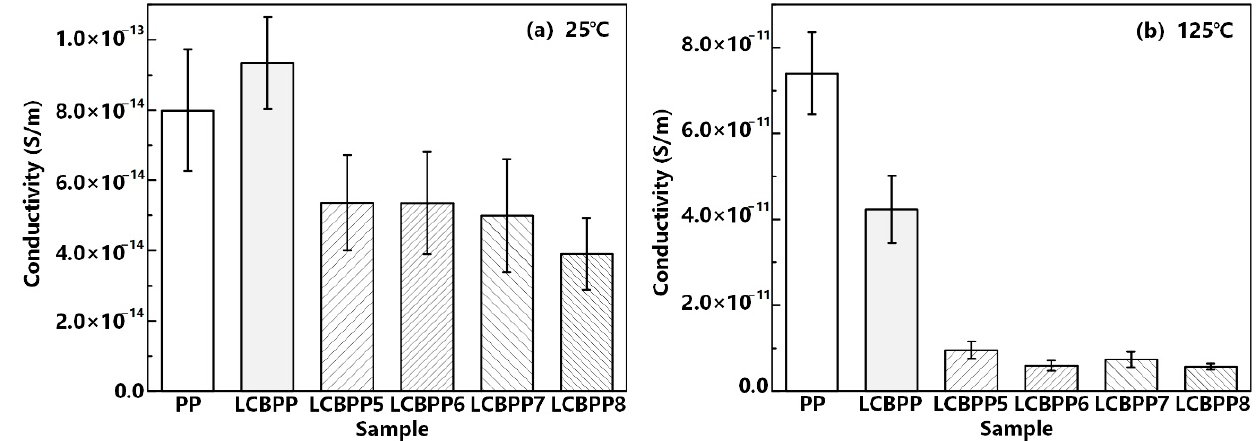
Figure 10. Relation between the conductivity and the β nucleating agents at different temperatures.